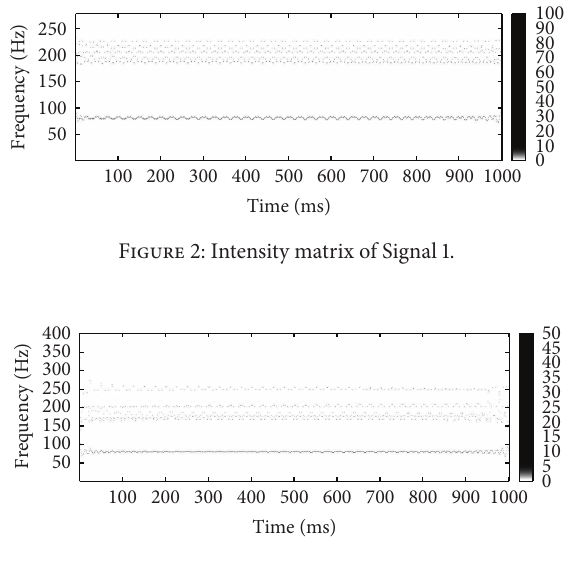
Figure 3: Intensity matrix of Signal 2.